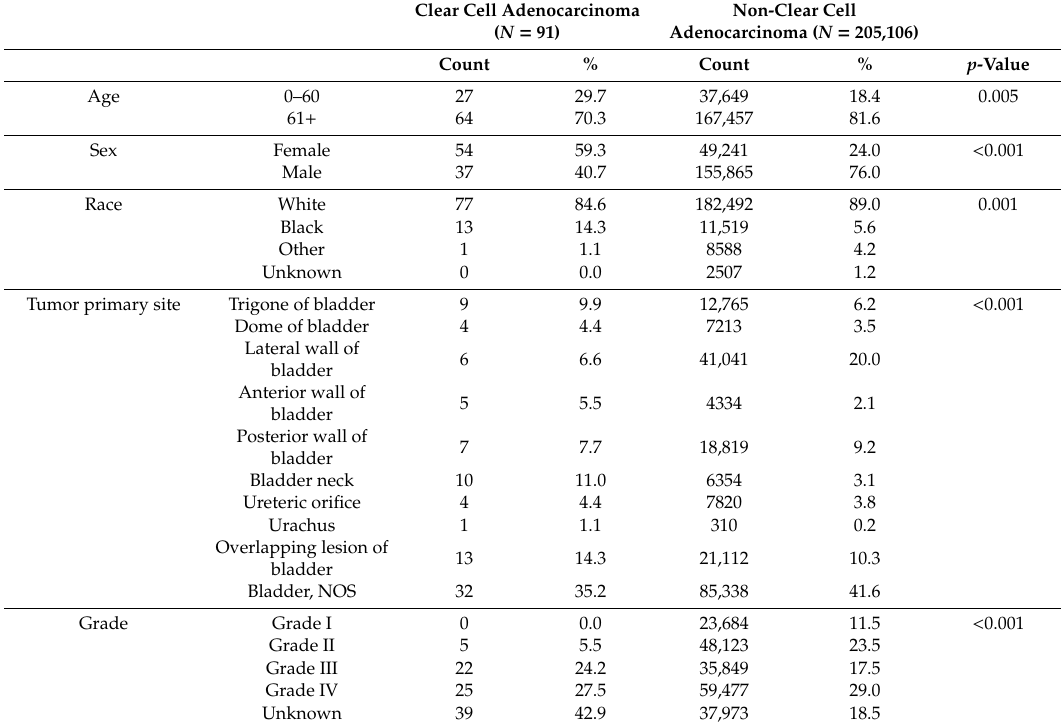
Table 1. Demographical and clinical characteristics comparing clear cell adenocarcinoma to other carcinomas of the urinary